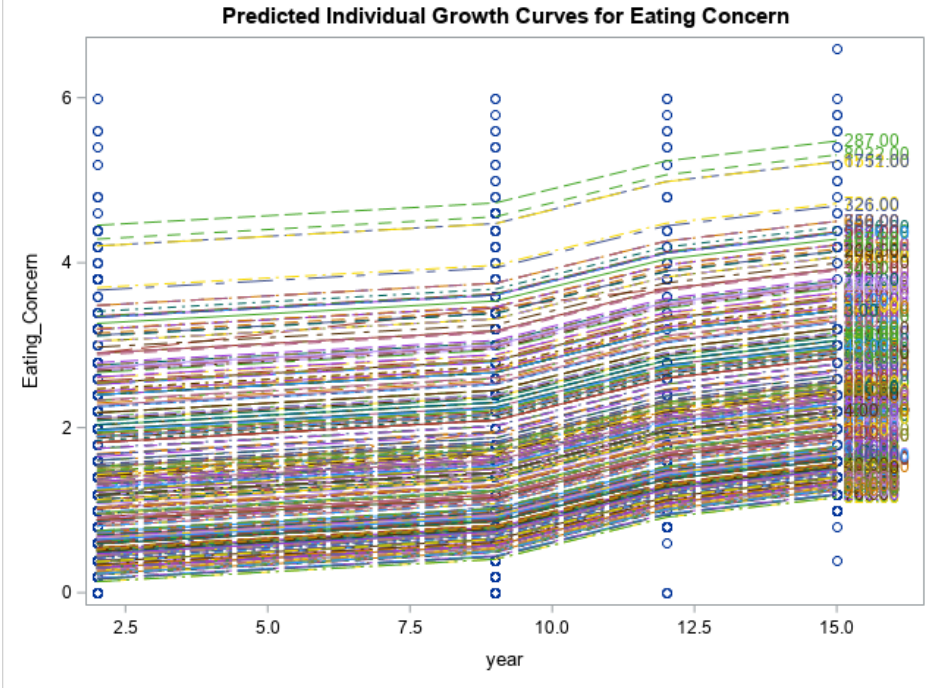
Figure 2. Predicted individual growth curves for shape concern. The blue lines indicate the measurement time points.